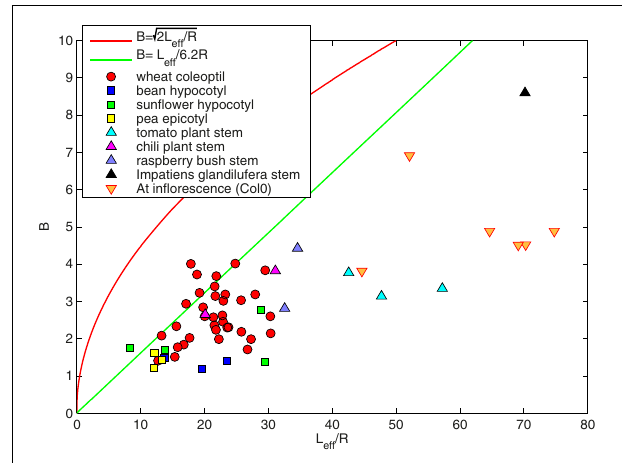
FIGURE 6 | B = L eff / L c as a function of the effective length of the organ L eff / R . Each point denotes an individual plant. The red line (cid:18) L eff / R . All the points are under this line B < represents B = showing that the destabilizing effects of growth on the whole gravitropic movement are negligible. The green line accounts for B = L eff / 6 . 2 R . Most of the points are under this line, showing that it is not possible to distinguish the steady state of the AC ˙ E model from the AC